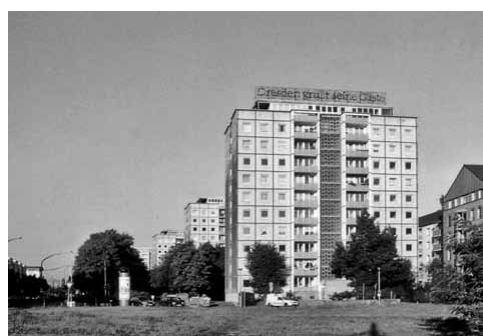
fig. 8. Dresden grüßt seine Gäste . Postplatz,